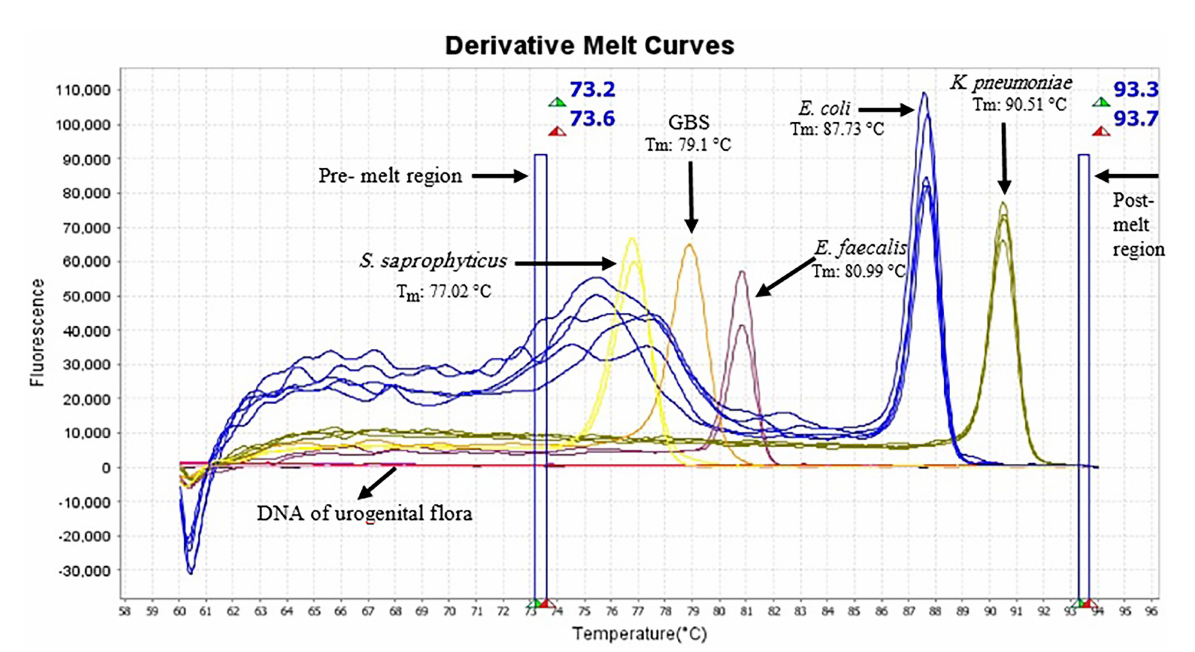
FIGURE 1 Derivative melting curves of HRM analysis of five different species generated from urine samples, each displaying a unique profile with respect to shape and melting temperature. Each line represents one sample and the same colors illustrate the same pathogens. Yellow curve ( S. saprophyticus , n = 2); light orange (GBS, n = 1); plum ( E. faecalis , n = 2); blue ( E. coli , n = 5) and dark yellow ( K. pneumoniae , n = 4). Pre-melt region: The set of lines to the left of the peak displays the pre-melt start and stop temperatures when every amplicon is double-stranded. Post-melt region: The set of lines to the right of the peak displays the post-melt start and stop temperatures when every amplicon is single-stranded. The HRM analysis was performed with a pre-melt region 73.2–73.6 ° C and a post-melt region 93.3–93.7 ° C. No amplification occurred in DNA samples of urogenital flora and therefore no melting curve was